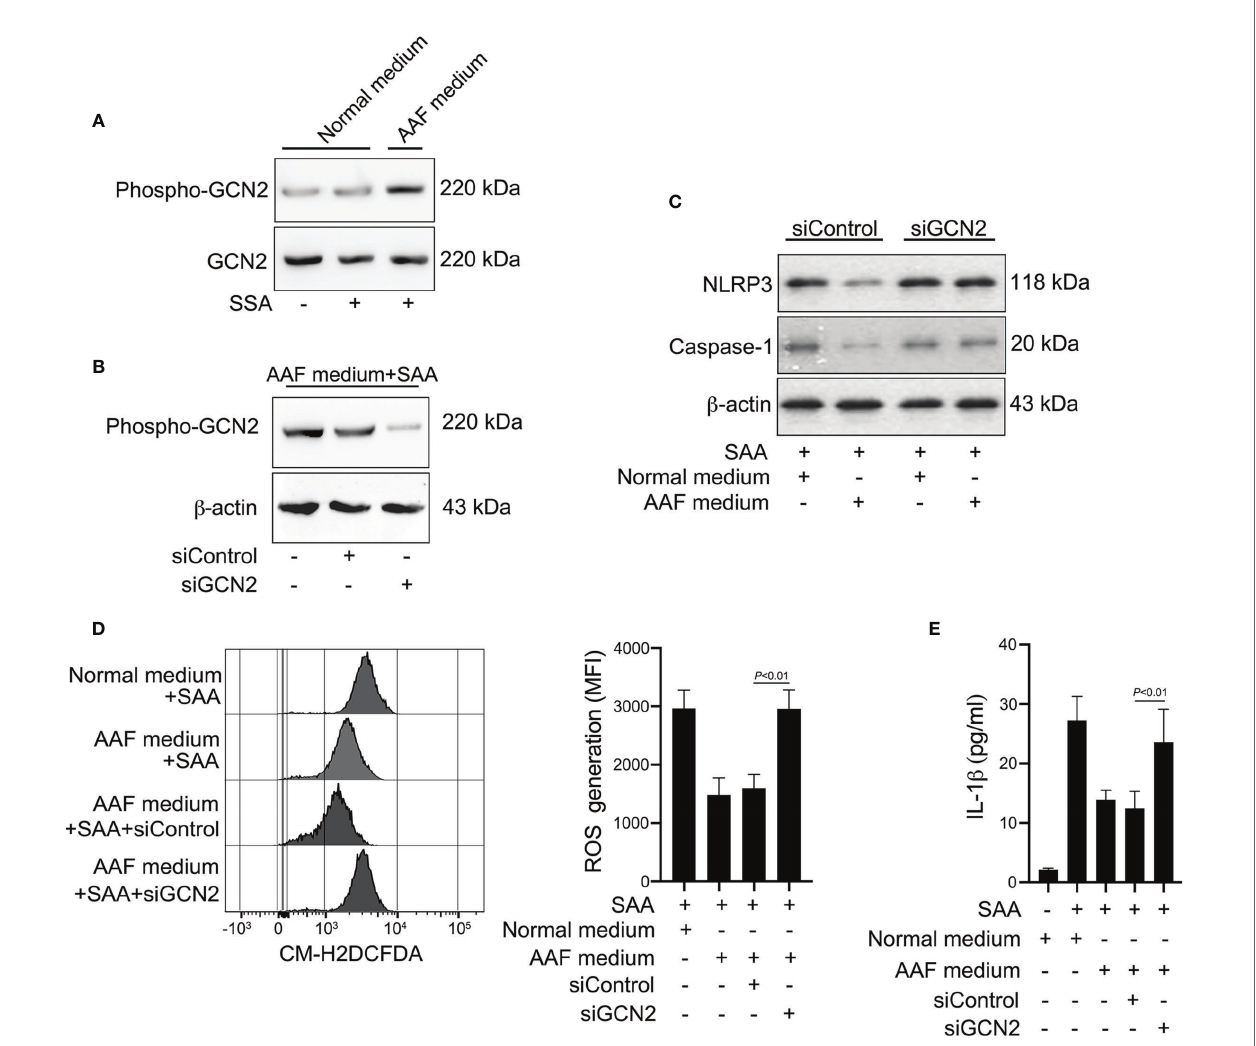
FIGURE 7 | Involvement of GCN2 in the effects of amino acid starvation. (A) Healthy monocytes were stimulated with SAA in the presence of normal complete medium or AAF medium. Protein expression of phosphor-GCN2 and GCN2 were measured by Western blot. Data are from one experiment representative of four. (B) Healthy monocytes were transfected by siRNA targeting GCN2 (siGCN2) or a non-speci fi c siRNA (siControl). GCN2 protein was examined by Western blot. Data are from one analysis representative of four. (C) siRNA-transfected monocytes were treated with 10 m g/ml SAA for 24 h in the presence of normal complete medium or AAF medium. NLRP3 and the active caspase-1 were measured by Western blot. Representative blots of four independent analyses are shown. (D) siRNA- transfected monocytes were then cultured with 10 m g/ml SAA under AAF condition for 24 h Then the melanocytes were stained by CM-H2DCFDA, and ROS generation was tested using fl ow cytometry. Representative histograms and MFI were acquired from four independent analyses. (E) siRNA-transfected monocytes were then stimulated by SAA (10 m g/ml) plus AAF medium, and culture supernatants were tested for IL-1 b . The data represent the mean ± SD of four